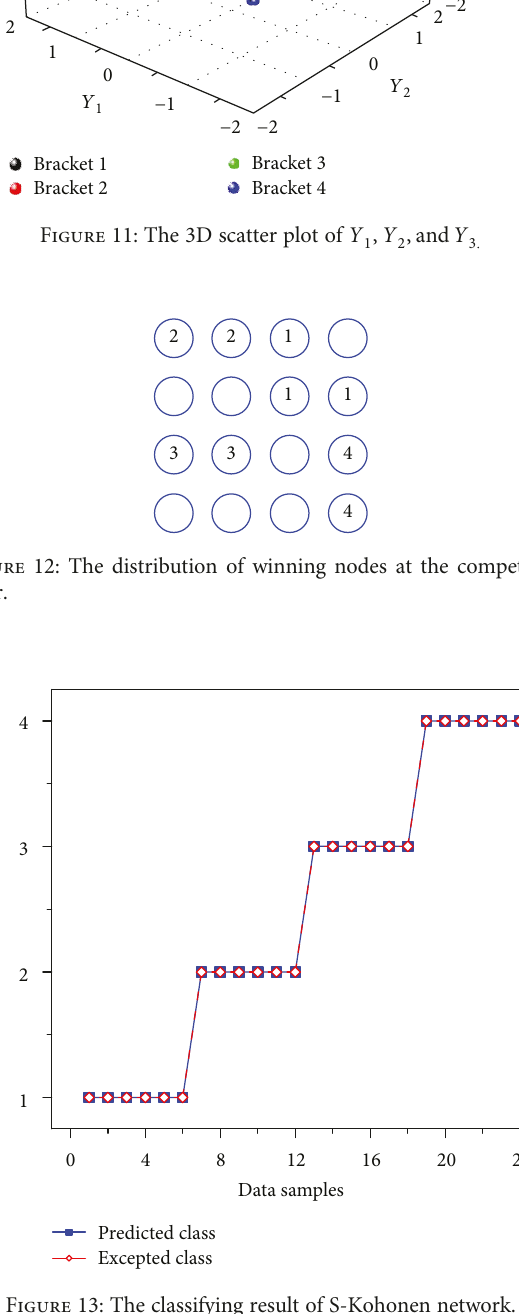
Figure 13: The classifying result of S-Kohonen